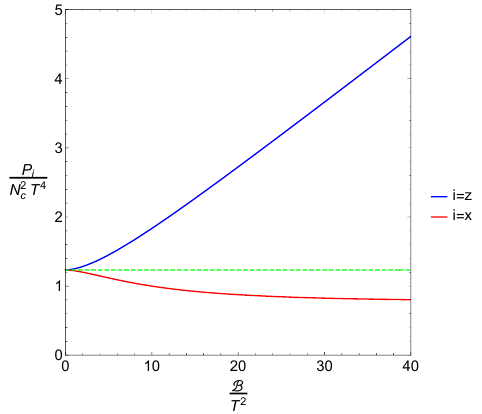
Figure 6 . The dimensionless longitudinal pressure P z /T 4 (blue) and the dimensionless transverse pressure P x /T 4 (red), both divided by N 2 , as functions of b = B /T 2 . The green dashed line depicts c the limiting case b = 0